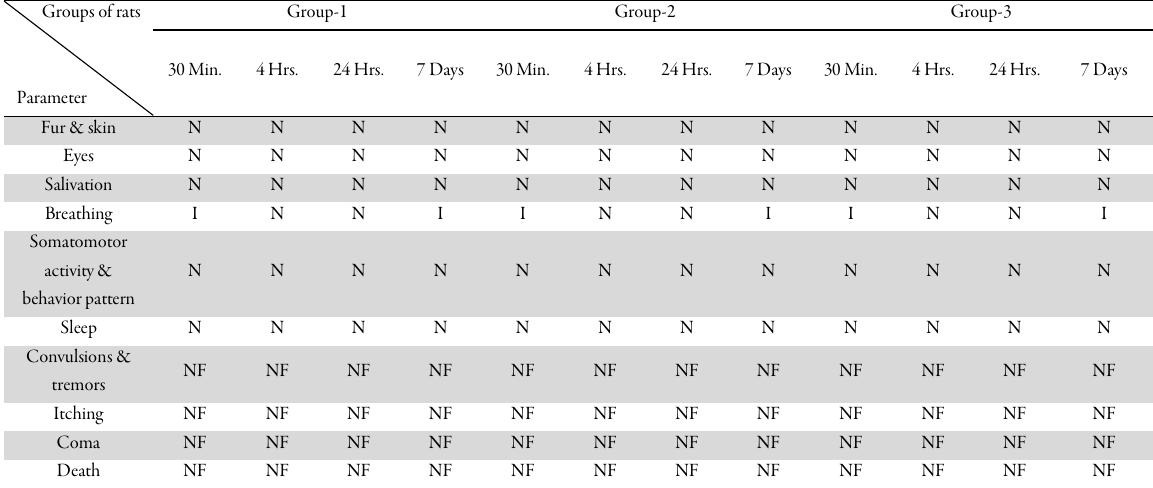
Table 6. Behavioural symptoms of rats treated with vehicle, SNPs 200 mg/kg and 400 mg/kg. N=nontoxic effect, I=increase, NF=not found Groups of rats